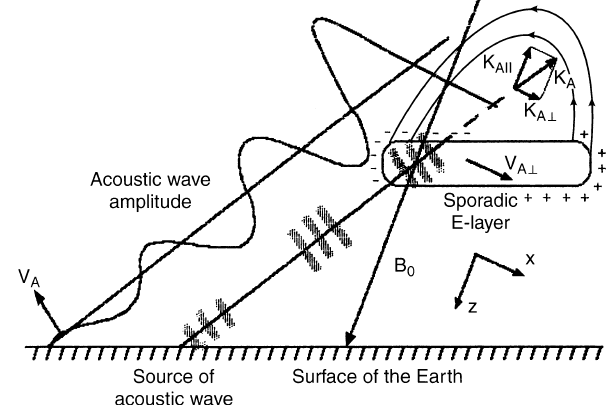
Fig. 1. Acoustic wave reaching the E region and causing an neutral- wind spike. ~ V A designates the component of neutral wind-velocity ? perpendicular to the geomagnetic field ~ B o . The neutral wind generates electrical currents in the E s -layer, which are closed by currents in the environmental plasma of the E region or by currents in a further E s - layer connected with the first E s -layer by the same geomagnetic field lines. The system of field-aligned and perpendicular to ~ B o currents is three-dimensional. Currents perpendicular to the plane of the figure are